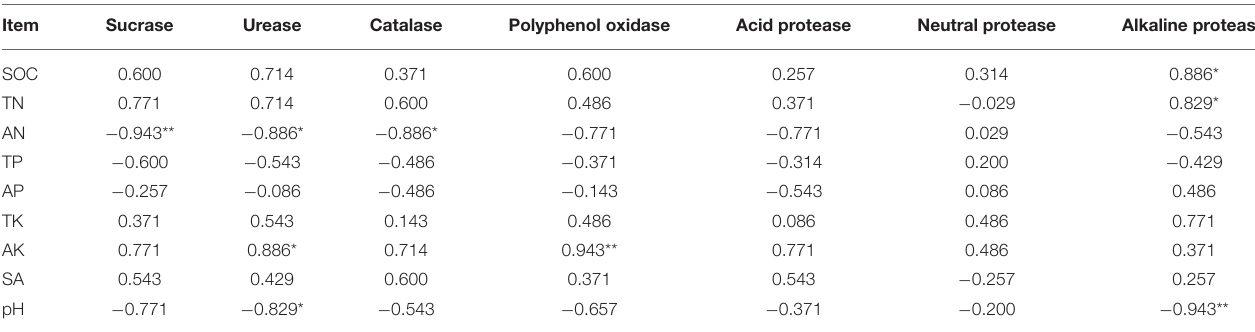
TABLE 6 | Correlations of soil properties with soil enzyme